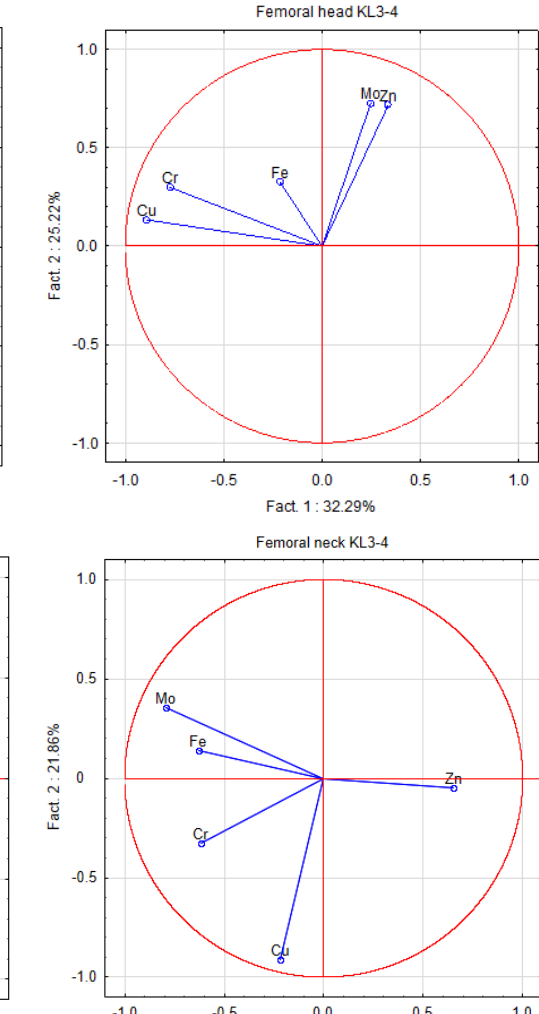
Table 4. Spearman’s correlation coefficients for the metals found in the femoral neck for mild and severe grades of OA.